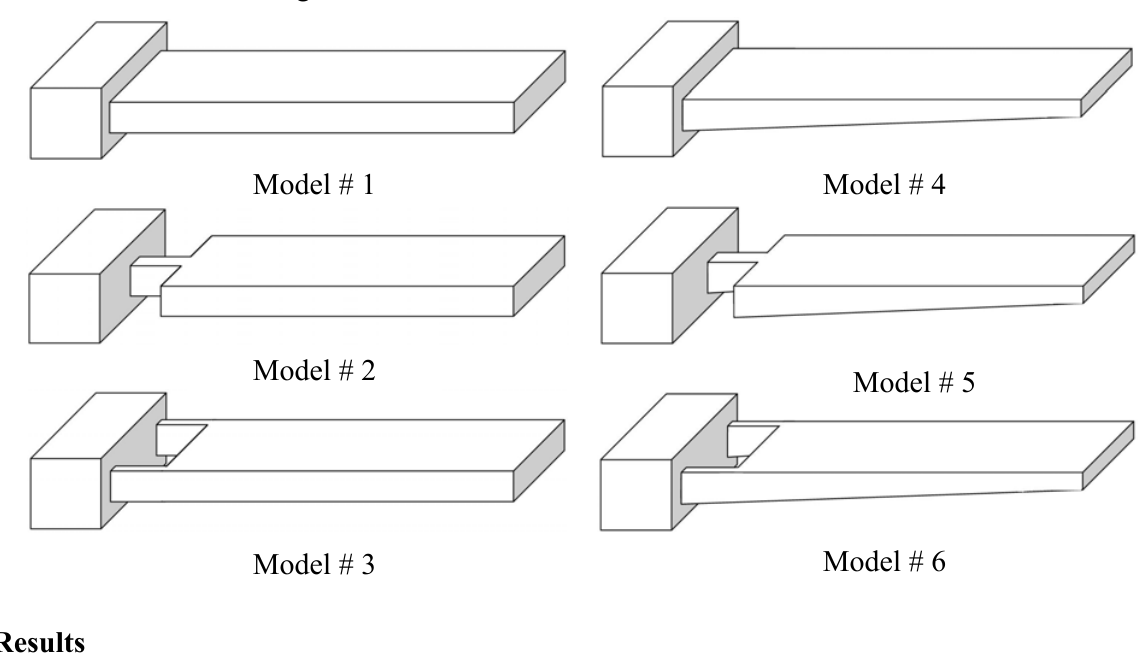
Figure 2. Schematic designs for the rectangular and trapezoidal profile cantilevers. All the models have same length and fixed-end thickness.